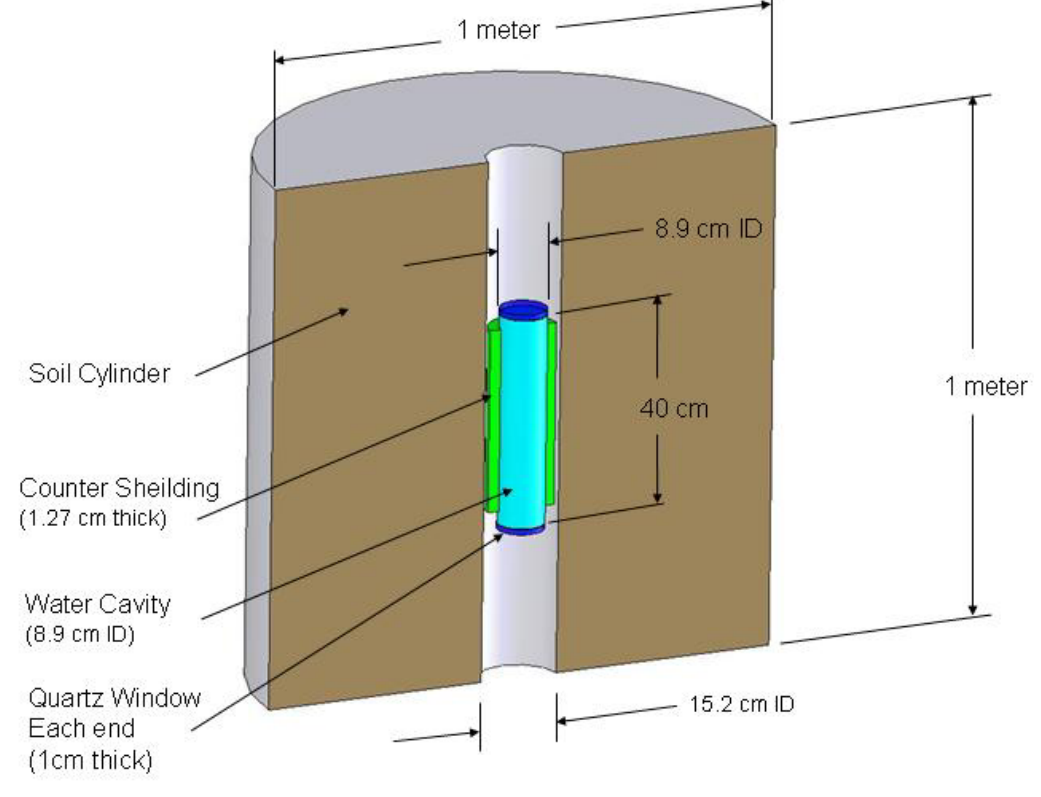
Figure 3. The simulation geometry includes a water cavity, shielding (active or passive), and surrounding soil. Essentially all of the gamma-ray flux entering the counter is accounted for with the 1-m right circular cylinder of soil shown here. Not shown in the figure is a disk above the counter from which trajectories of cosmic rays were